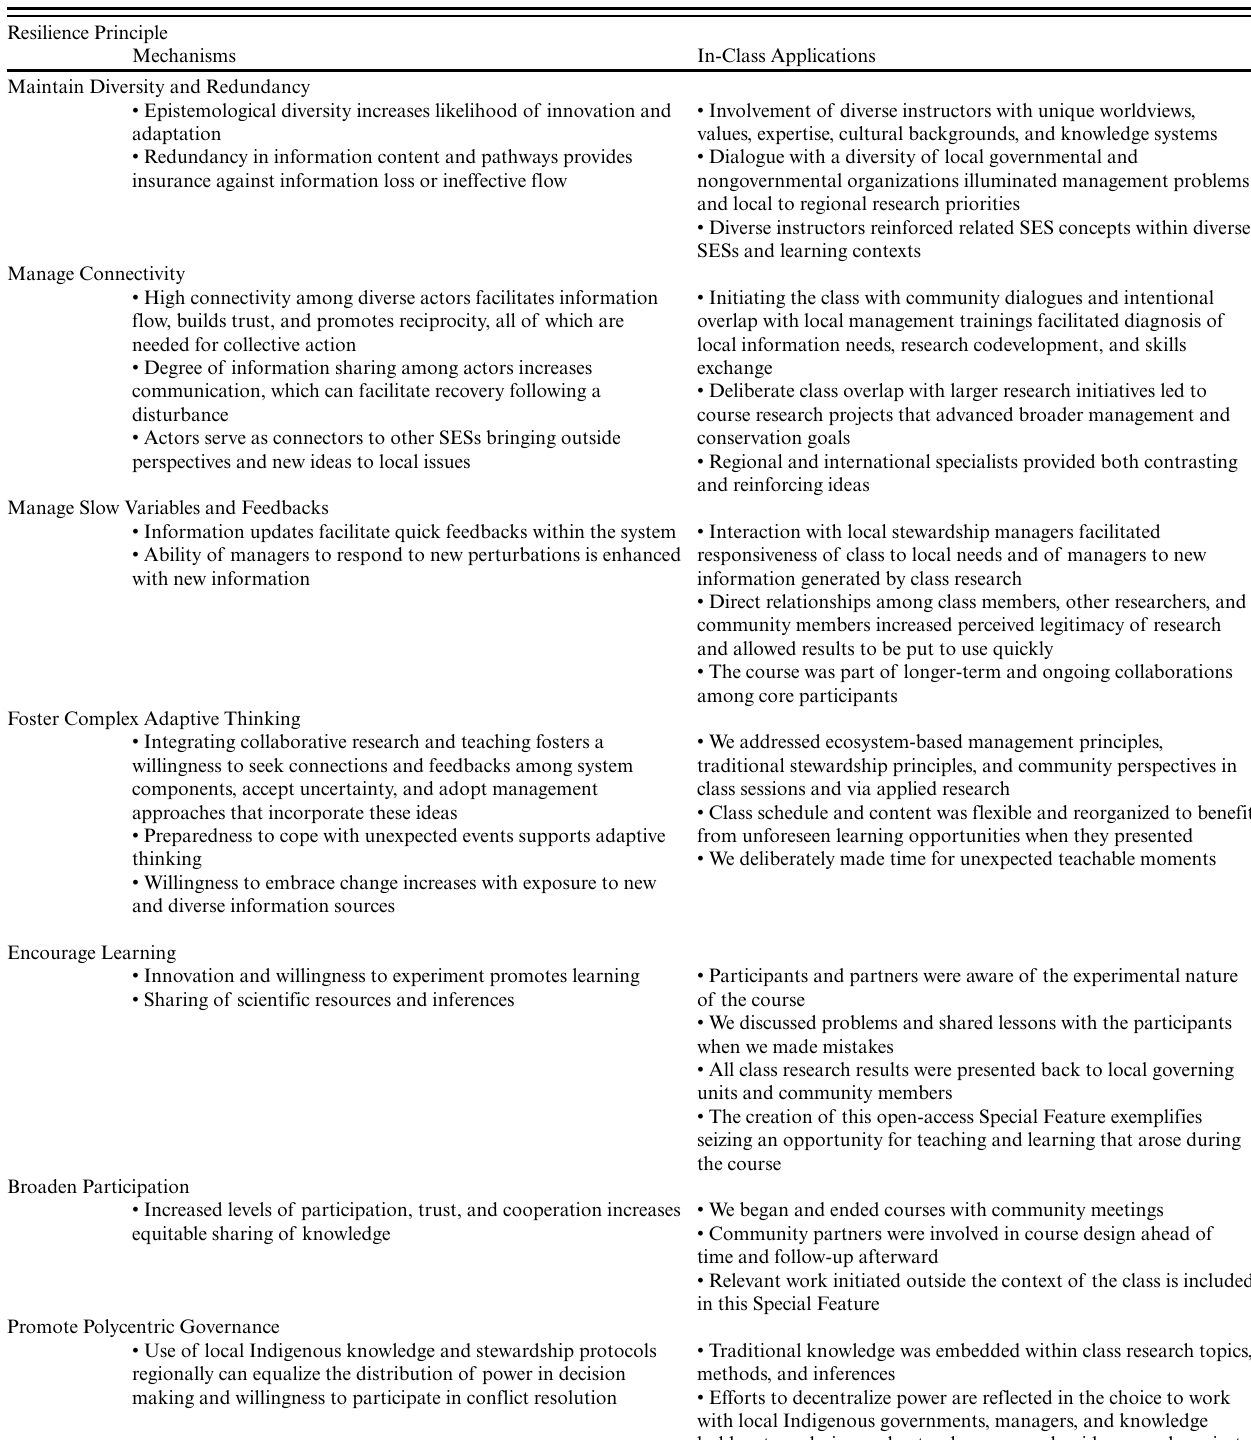
Table 1 . Hypothesized mechanisms and empirical examples by which integrating collaborative information generation (i.e., research) and flow among actors (i.e., teaching and mentoring) can enable the coproduction of knowledge and build resilience of a social- ecological system (SES) based on seven resilience principles described by Biggs et al. (2012). This structure could be used for designing and testing field courses and training programs as experiments in resilience thinking and